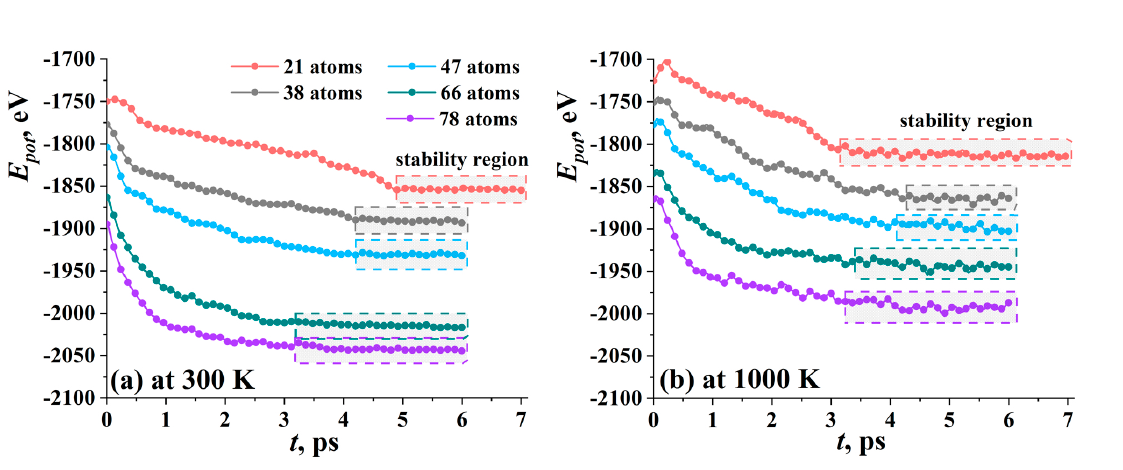
Figure 2. Potential energy as the function of exposure time at 300 K ( a ) and 1000 K ( b ) for five types of nanoclusters. In Figure 3, the process of crumpling for nanoclusters Ni 21 (a), Ni 47 (b) and Ni 66 (c) was shown in details after exposure at 300 K (blue line) and 1000 K (red line).